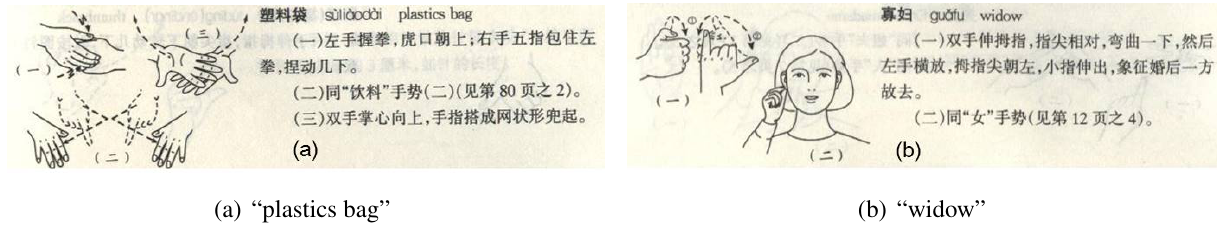
Figure 1. Sign gestures edited by China Association of the Deaf. ( a ) Chinese word “plastics bag”; ( b ) Chinese word